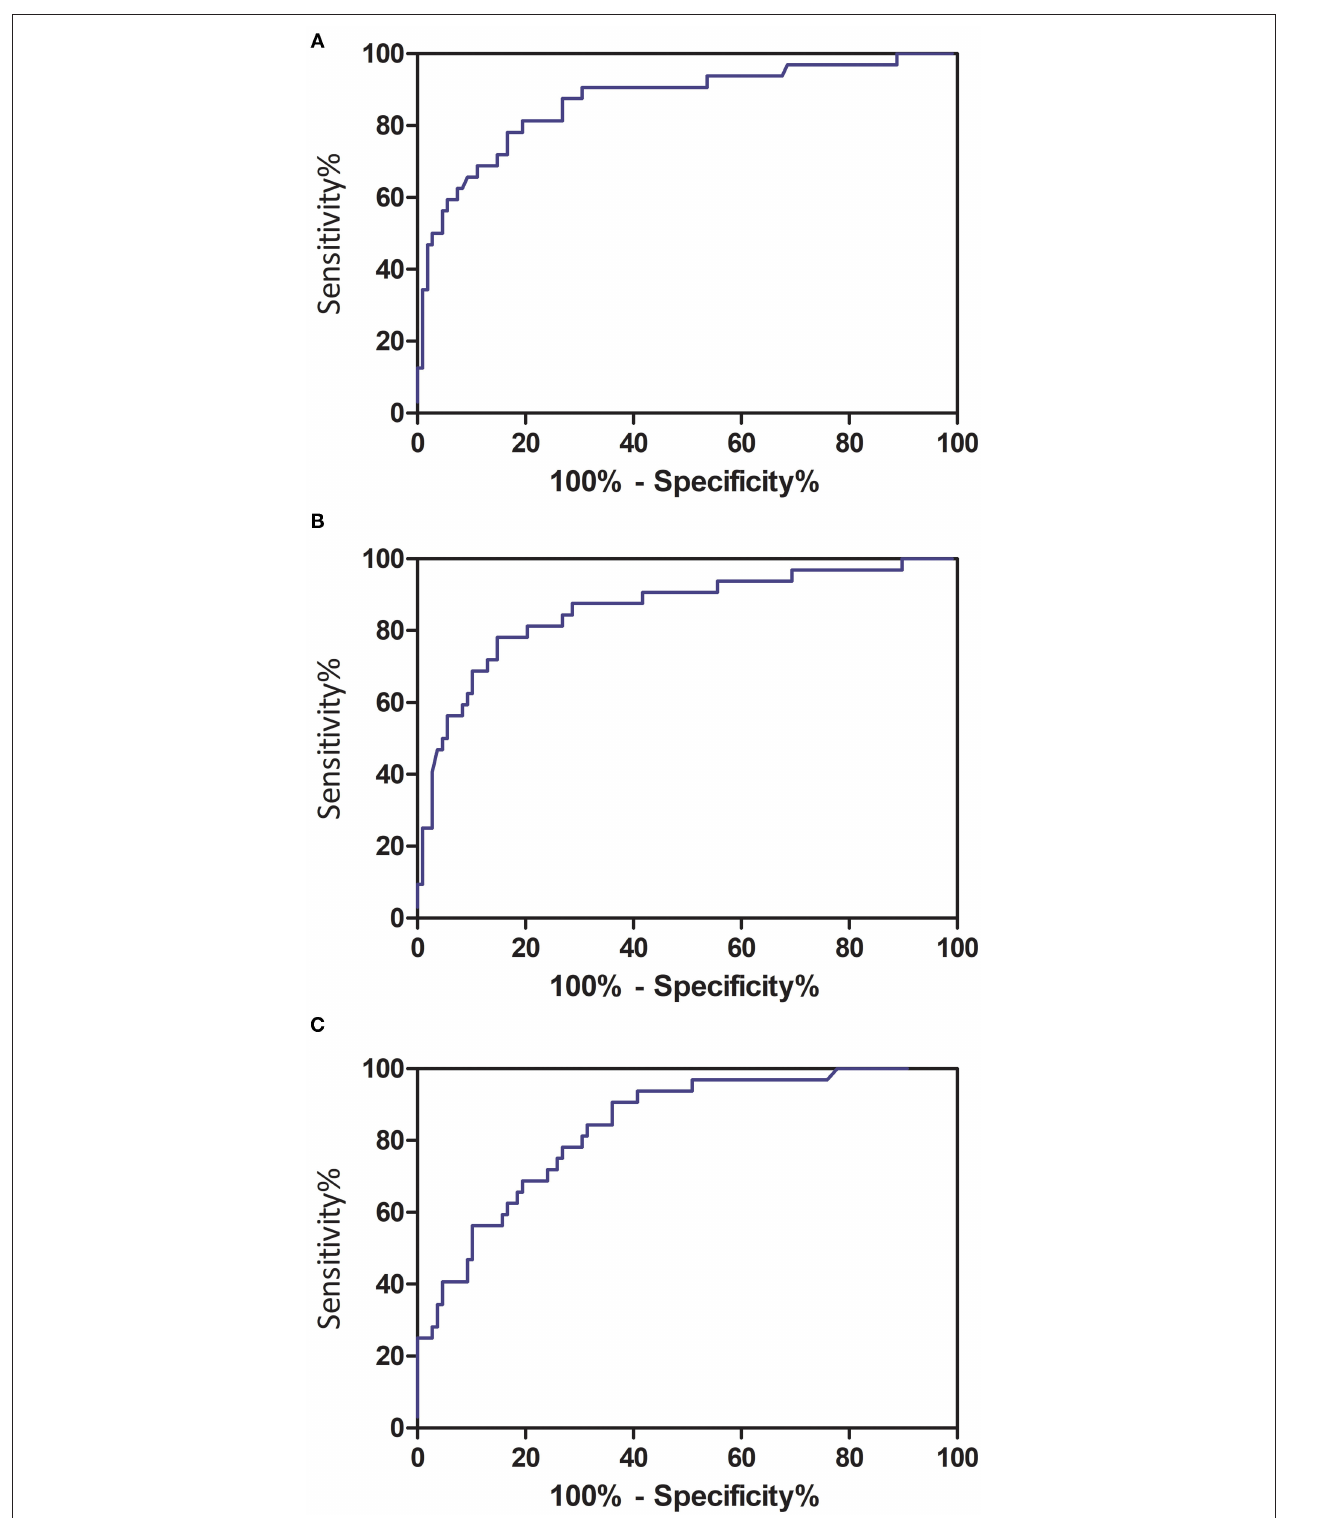
FIGURE 5 | Receiver operating characteristic curve analyses of quantitative CT features in predicting critical illness among COVID-19 patients. (A) Total pneumonia volume in both lungs; (B) ground-glass opacity volume in both lungs; and (C) consolidation volume in both lungs.